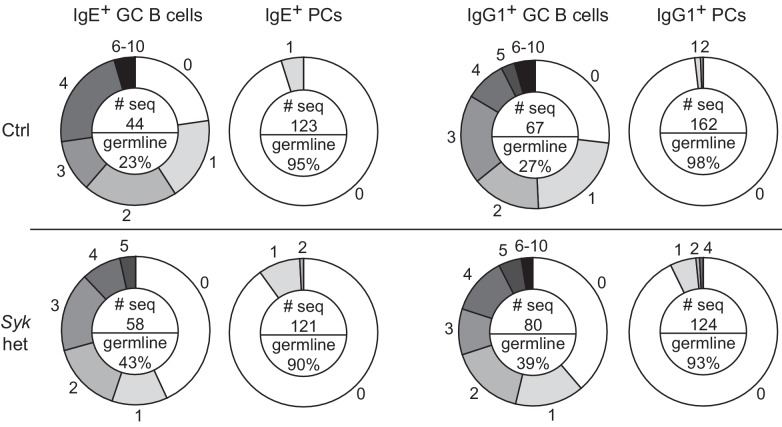
Frequency of somatic mutations in GC B cells versus PCs.Sequence analysis of VH186.2 amplified from single NP-specific GC B cells or PCs from draining lymph nodes of control Syk+/+ Cγ1Cre/+ (Ctrl) versus Sykflox/+ Cγ1Cre/+ (Syk het) mice. The numbers of mutations compared with the germline sequence are shown on the outer edges of the circles. The pie chart is shaded to represent the fraction of cells with the indicated number of mutations. An inset in the center of each pie chart shows the total number of sequences analyzed (# seq) and the frequency of germline sequences. GC B cells were identified as CD138–B220hiPNAhiCD38loIgDlo, total NPint, and intracellular IgEint or total IgG1int. PCs were CD138+B220lo-intPNAloCD38loIgDlo, total NPhi, and intracellular IgEhi or total IgG1hi. Mice were immunized subcutaneously with NP-CGG in alum adjuvant and draining lymph nodes were harvested 9 d later. Cells were sorted over two experiments from a total of 16 mice (Ctrl) and 17 mice (Syk het) and the sequences were pooled for analysis. We note that while there appear to be a higher frequency of GC B cells with germline sequences in Syk het mice, this was not consistent finding when the data were disaggregated by experiment. The high affinity mutation W33L was only present in a negligible number of sequences at this timepoint, as expected.